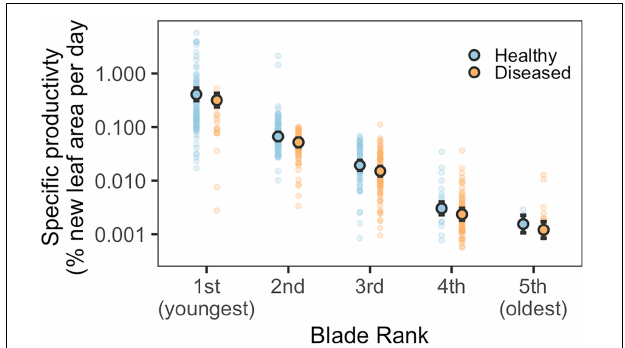
FIGURE 1 | Predicted specific productivity for diseased and healthy eelgrass blades of different ages, modeled as a function of blade rank (age) and disease status (note the log scale). Blade rank refers to blade age and position on each shoot (1st rank = youngest, 5th rank = 5th youngest). Outlined circles indicate mean predicted values, solid circles indicate underlying data. Error bars indicate 95% confidence intervals of the prediction.